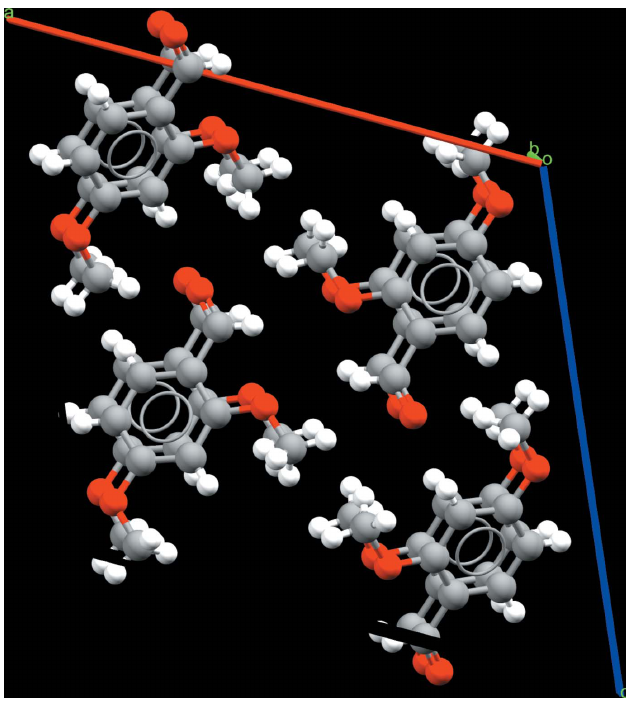
Figure 7 Aview along the a axis of the crystal structure of 2,5-DMBz, in which (cid:2) – (cid:2) stacking interactions between the aromatic rings are